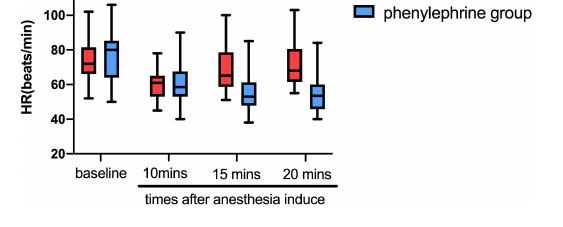
FIGURE3 The ephedrine group showed increased HR 5 min after ephedrine injection from 57.20 bpm ± 7.99 bpm